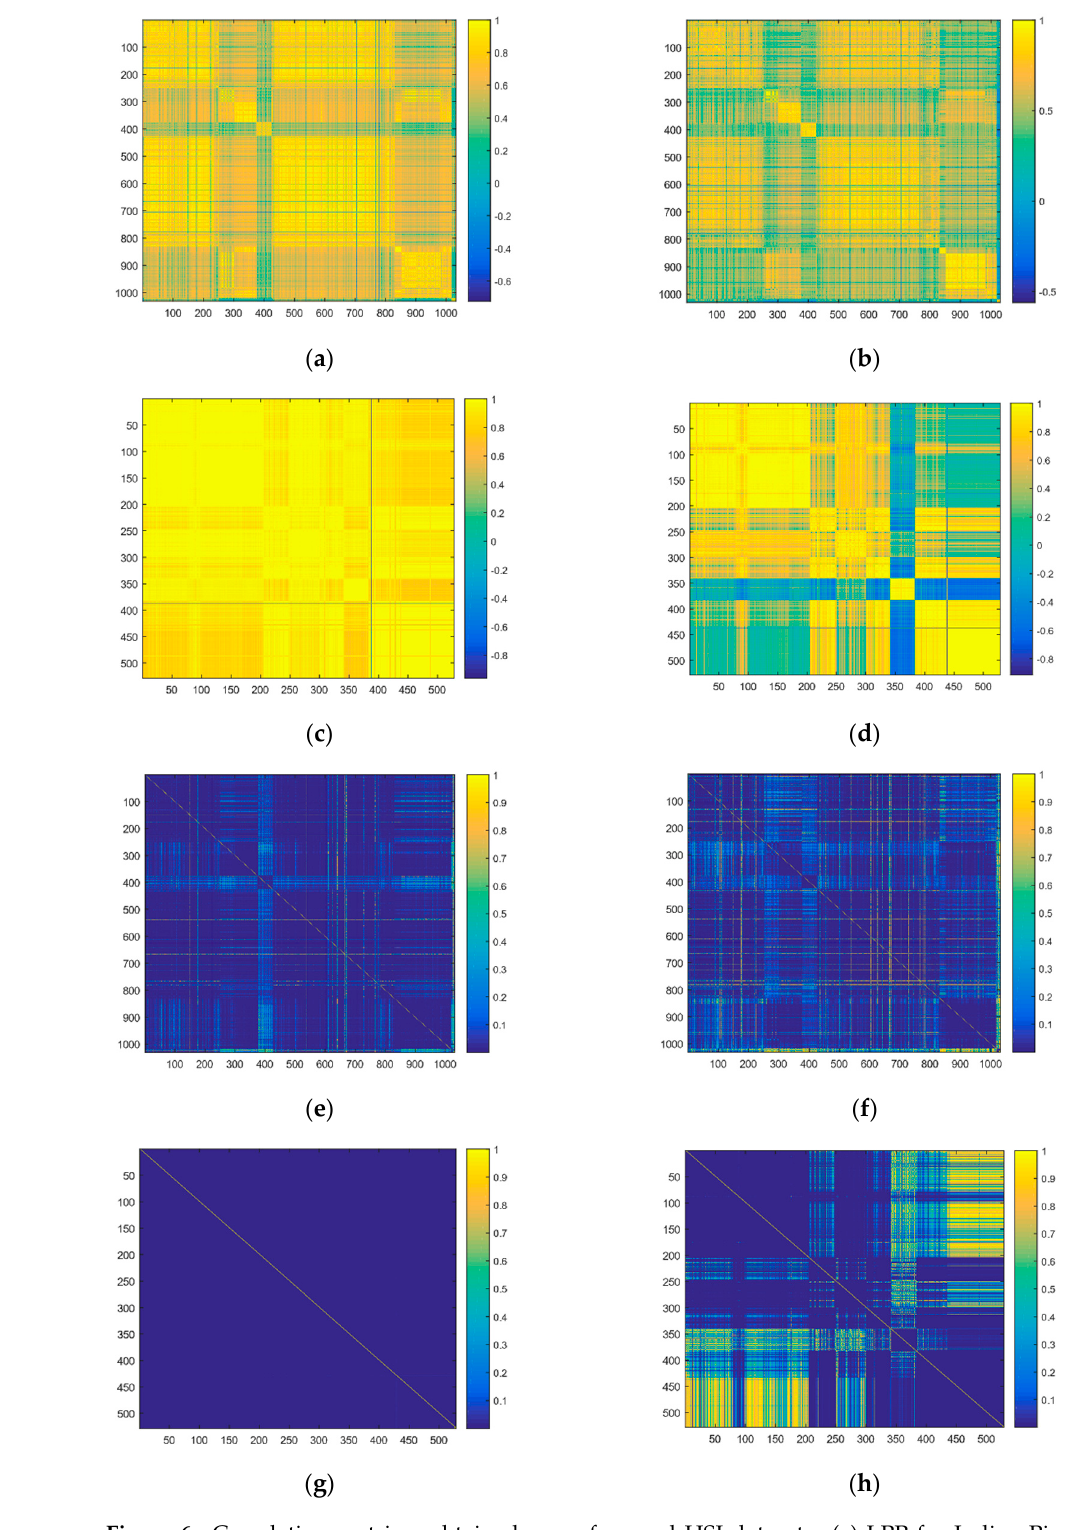
Figure 6. Correlation matrices obtained upon face and HSI datasets: ( a ) LPP for Indian Pines; ( b ) Proposed + LPP for Indian Pines; ( c ) OLPP for KSC; ( d ) Proposed + OLPP for KSC. Significance matrices ( p -values) for the correlations: ( e ) LPP for Indian Pines; ( f ) Proposed + LPP for Indian Pines; ( g ) OLPP for KSC; ( h ) Proposed + OLPP for KSC. (LPP: Locality Preserving Projection, OLPP: Orthogonal Locality Preserving Projection).